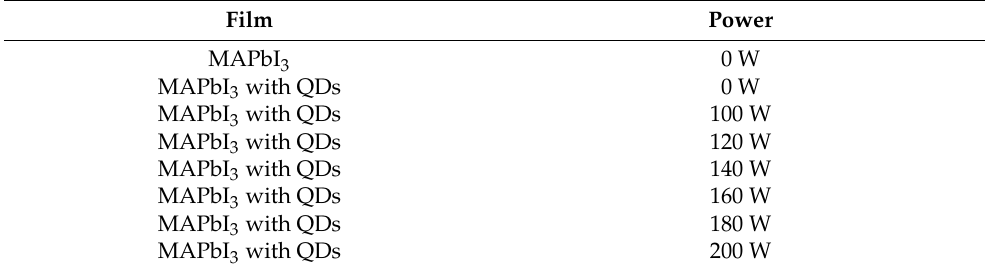
Table 2. Types of film and power range of argon plasma. Film Power MAPbI 3 0 W MAPbI 3 with